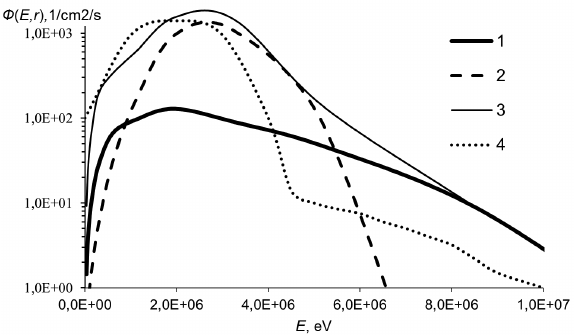
Figure 4. Spectrum of the neutron flux density at a distance of 50 cm from the PuO sphere: 1 – spontaneous fission (authors); 2 2 − (α,n)-reactions (authors); 3 – total spectrum (authors); 4 – total spectrum of PuO (Monte Carlo method (Taherzadeh and 2 Gingo Peter 1972)).